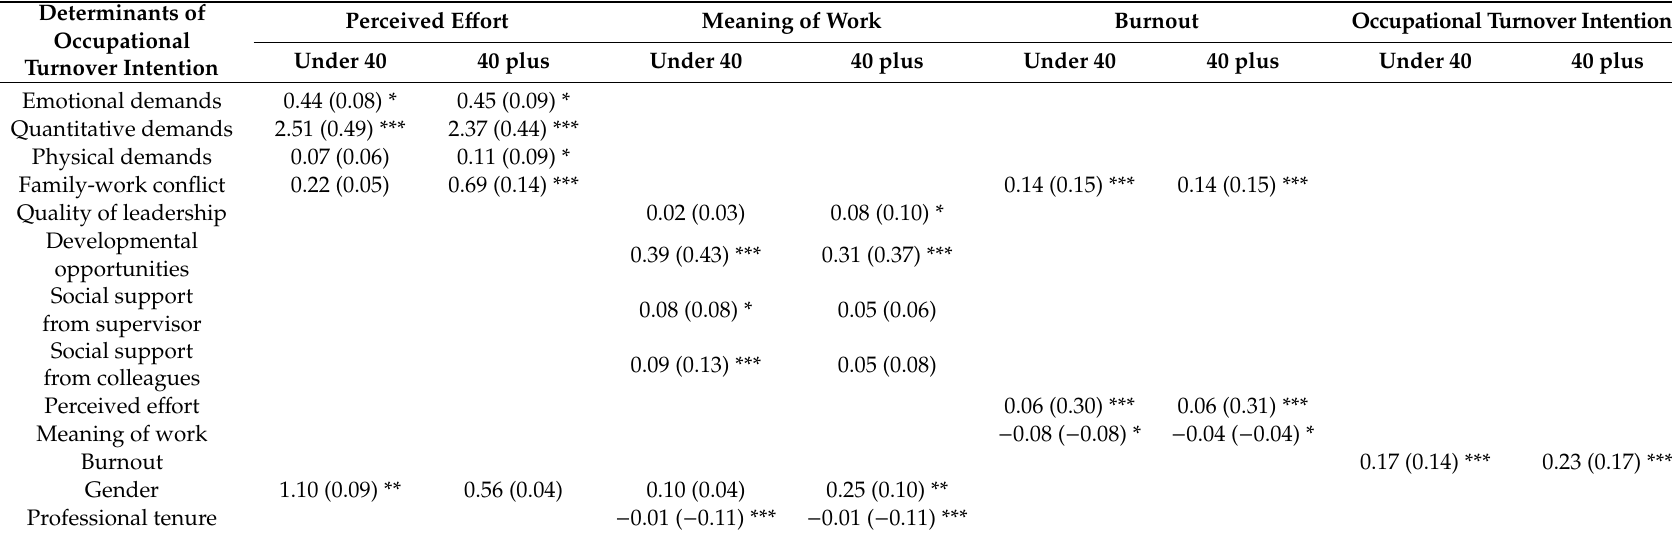
Table 5. Estimated Regression Coe ffi cients from the Structural Model for Each Age Group (standardized coe ffi cients in